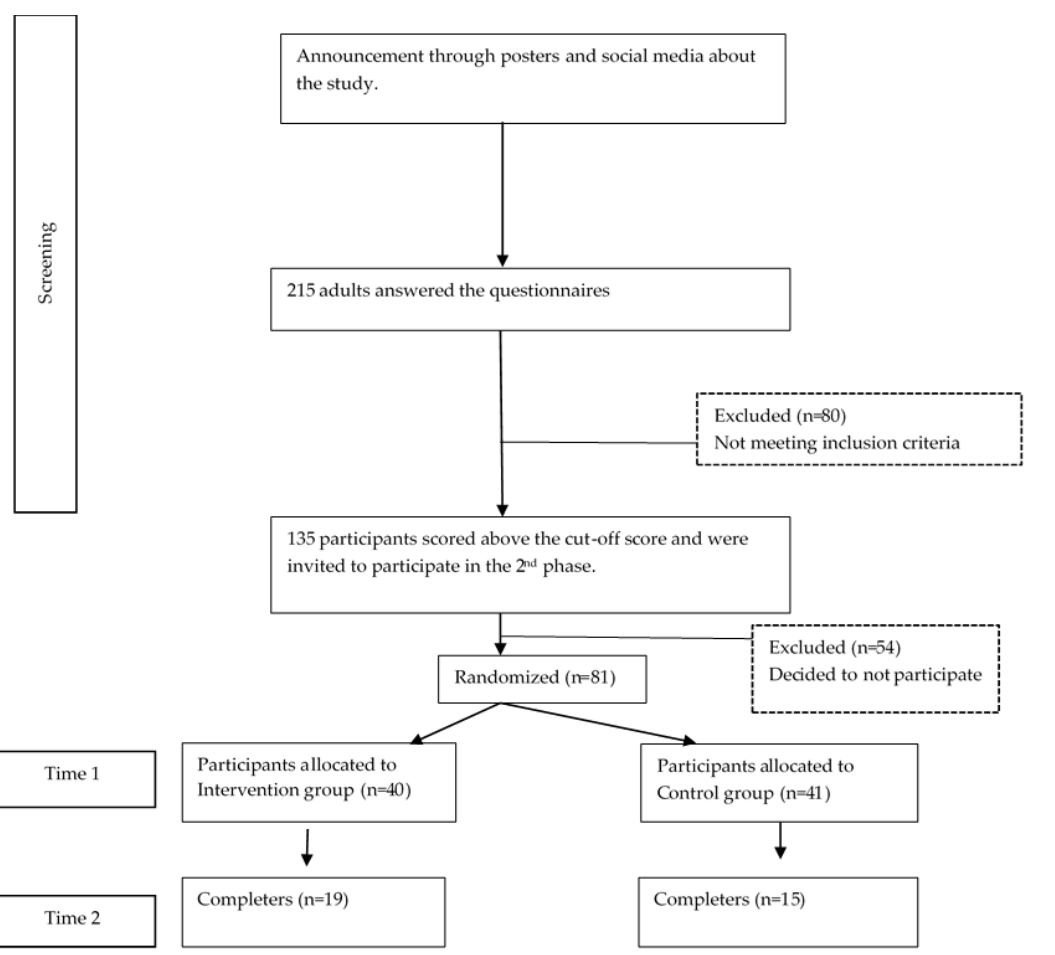
Figure 1. Flow chart of participants through the study .